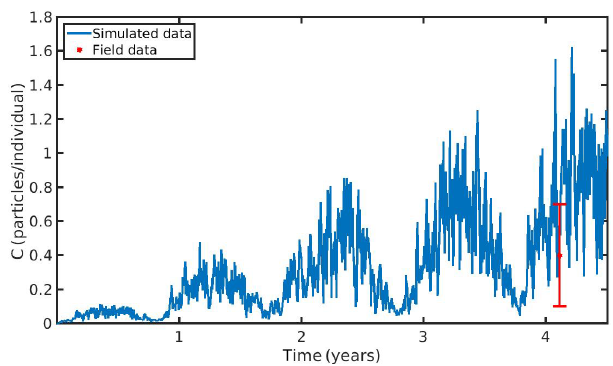
Figure 6. Microplastics (MPs) accumulation by the mussel (blue line) against field data (red star: mean ± SD), using daily envi- ronmental concentration of MPs ( C env mean value ± SD: 0 . 4 ± 0 . 3particlesL − 1 ) in the North Sea.